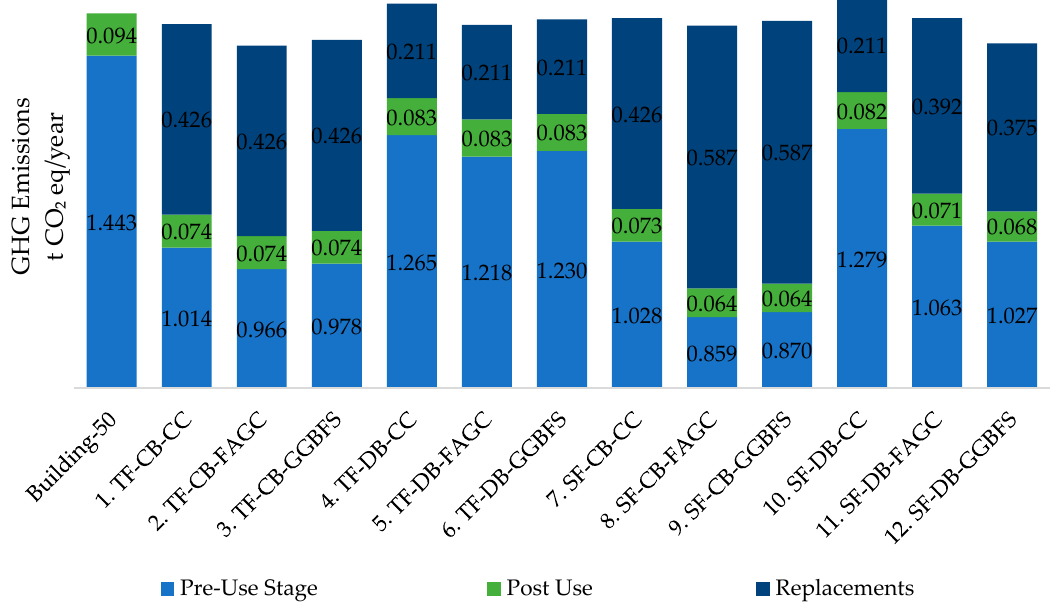
Figure 4. Life cycle greenhouse gas (GHG) emissions per year per building for 12 buildings and Building-50. (Use stage is omitted in the graph as the use-stage GHG value 9.918 t CO 2 eq/year is uniform in all cases and if plotted on same scale, other stages due to low values cannot be presented properly).